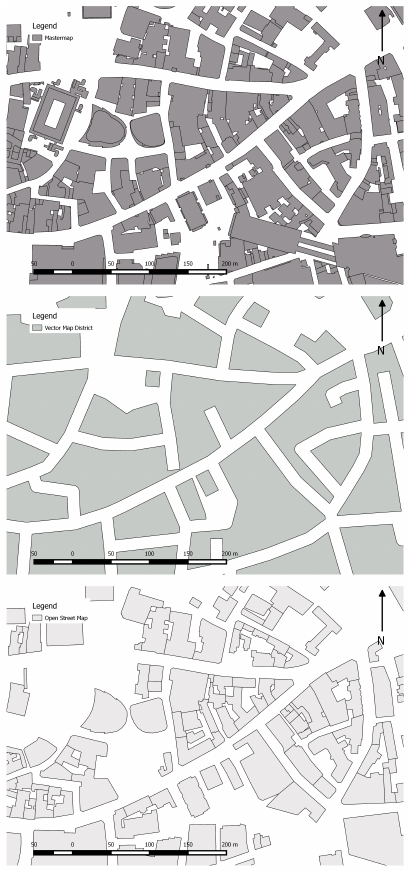
Figure 3: OS MasterMap (top) and Vector Map District (middle), OpenStreetMap